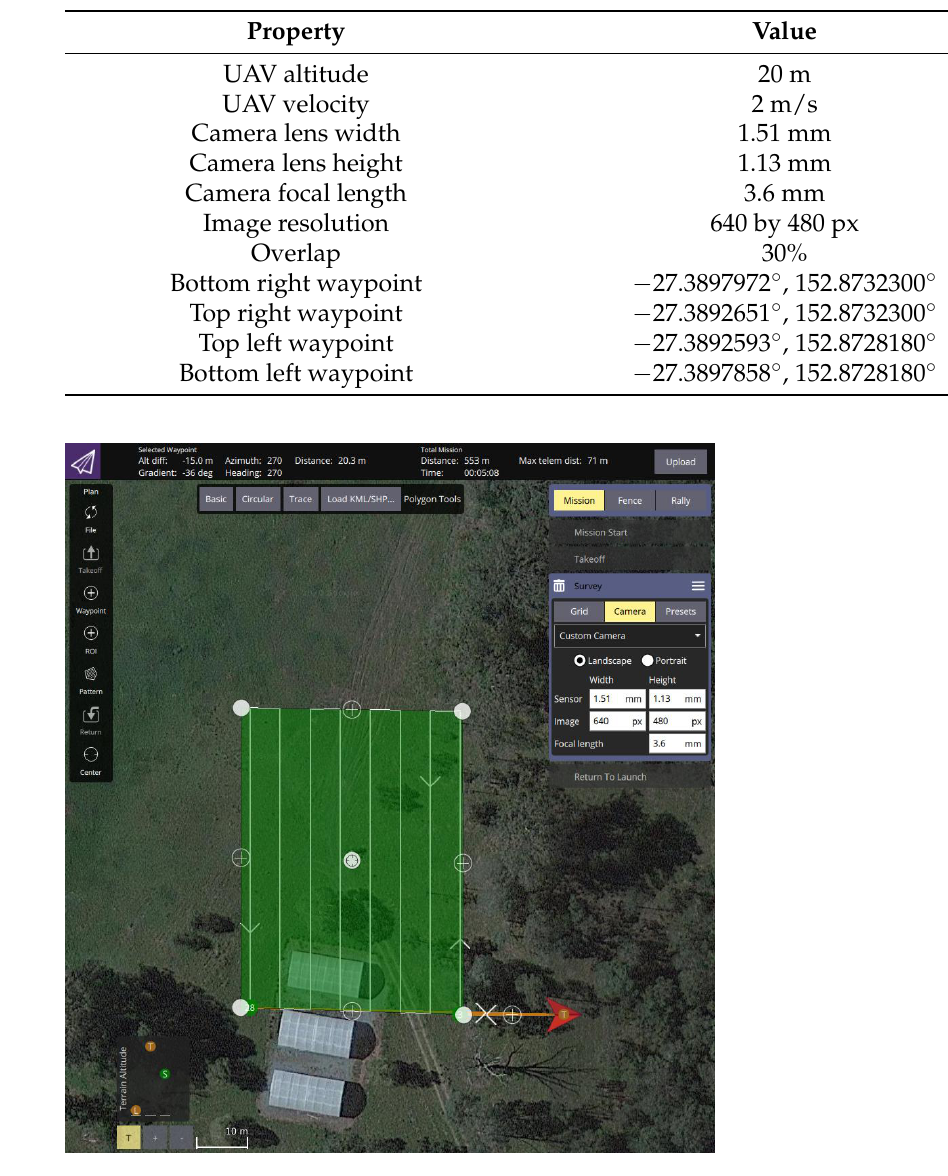
Figure 10. Designed flight plan that the UAV follows in mission mode. The survey is set for a single pass of the setup at a constant height of 20 m, UAV velocity of 2 m/s, and overlap of